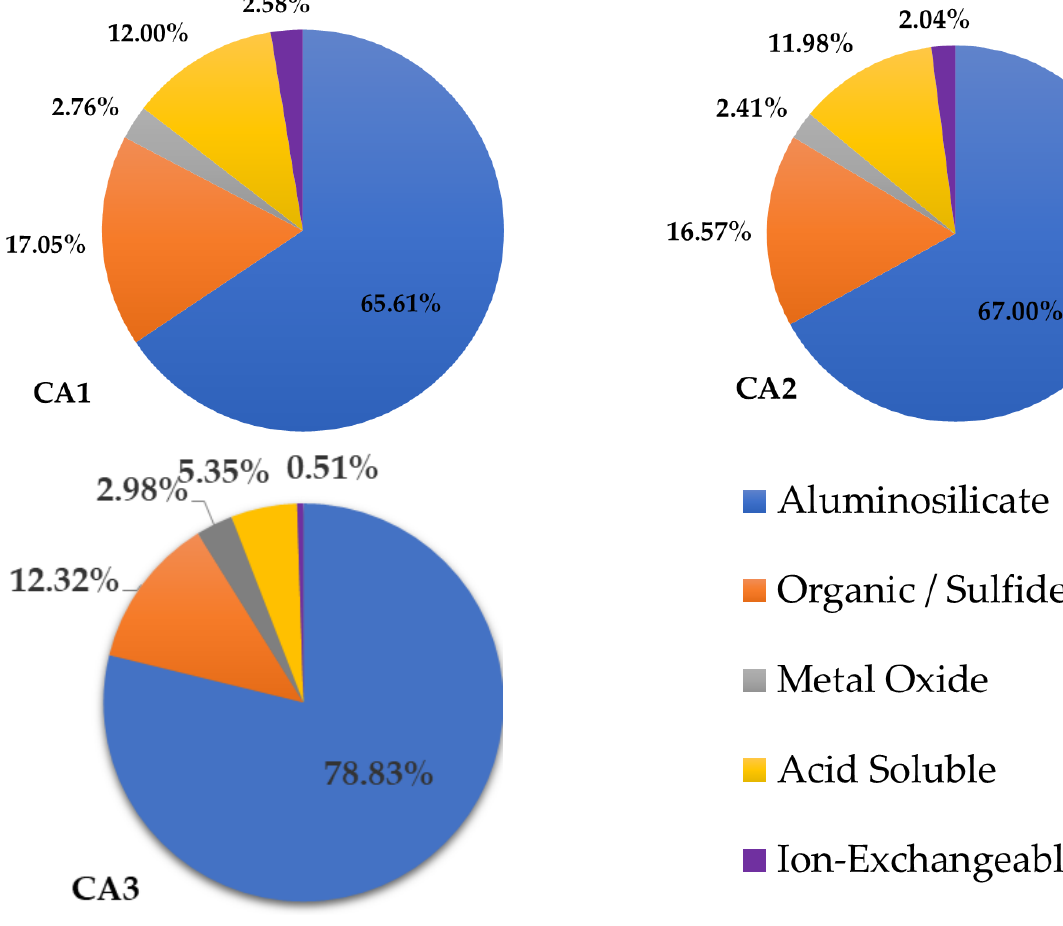
Figure 6. Modes of occurrence of rare earth elements in three samples.